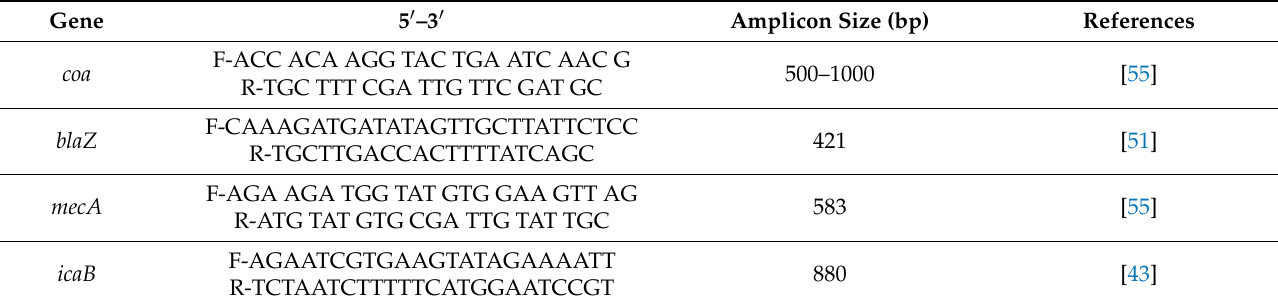
Table 4. Primers used in the